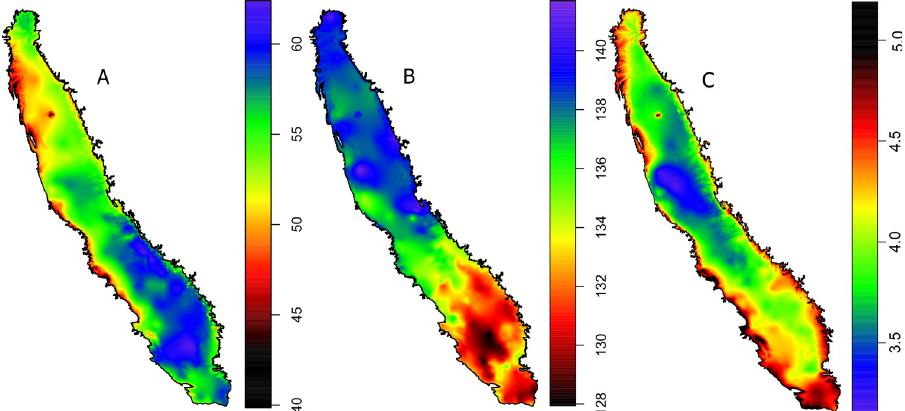
Fig 5. Interpolation of Almond full bloom prediction after the sequential completion of chill requirement (23CP) and heat requirement (300 GDD Tb4.5 ) (A), 1% Hullsplit prediction after using the GDD Tb5_Tm35 during the 90 days after flowering in a linear regression model proposed by Tombessi et al. [35] (B), and number of NOW generations predicted using the accumulation of GDD Tb12.7_Tm35 [4] (C) for season 2020 using data from CIMIS and 731 in- orchard